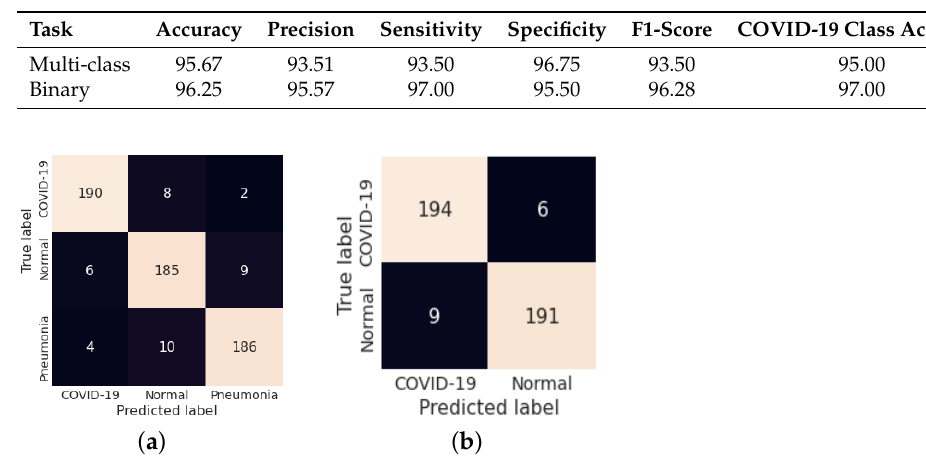
Table 7. Classification performance (in %) of LW-CORONet on Dataset-2.